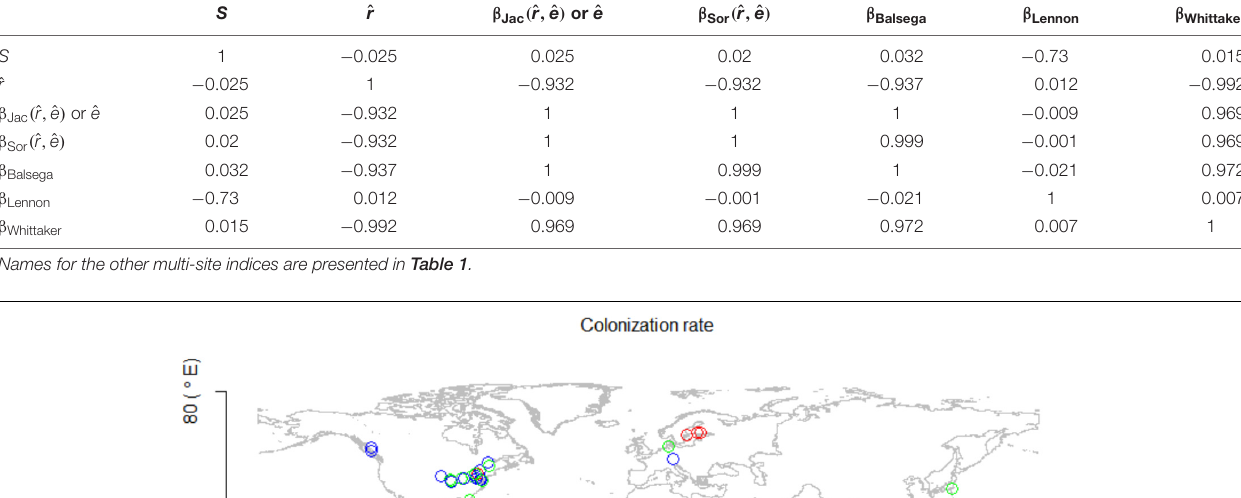
TABLE 3 | Relationships (measured by the correlation coefficient) of the colonization rate, extinction rate, and multi-site beta diversity estimated using the proposed likelihood model and other multi-site calculation methods in a numerical simulation when species richness ( S ) varies. S ˆ r β Jac ( ˆ r , ˆ e ) or ˆ e